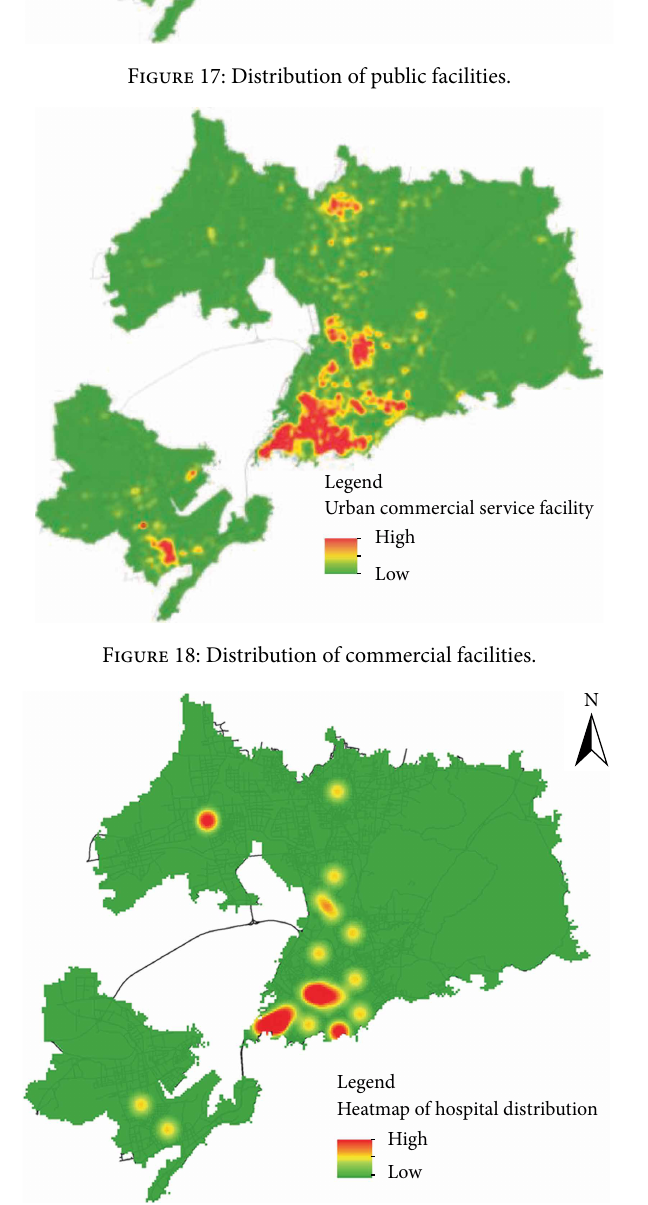
Figure 19: Distribution of hospitals.